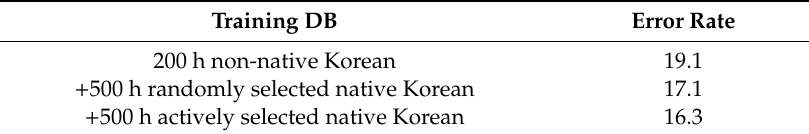
Table 3. Comparison of syllable error rate (%) on the non-native Korean speech recognition task, comparing the models trained using the speech database (DB) selected by the proposed active learning method and a random selection method.